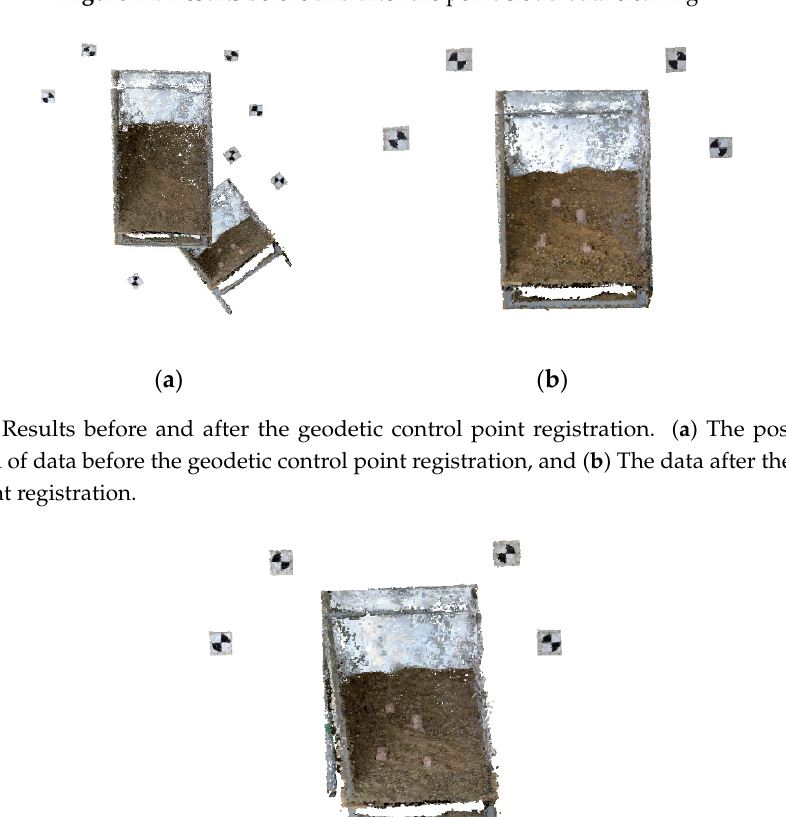
Figure 13. Results before and after the geodetic control point registration. ( a ) The position and distribution of data before the geodetic control point registration, and ( b ) The data after the geodetic control point registration.